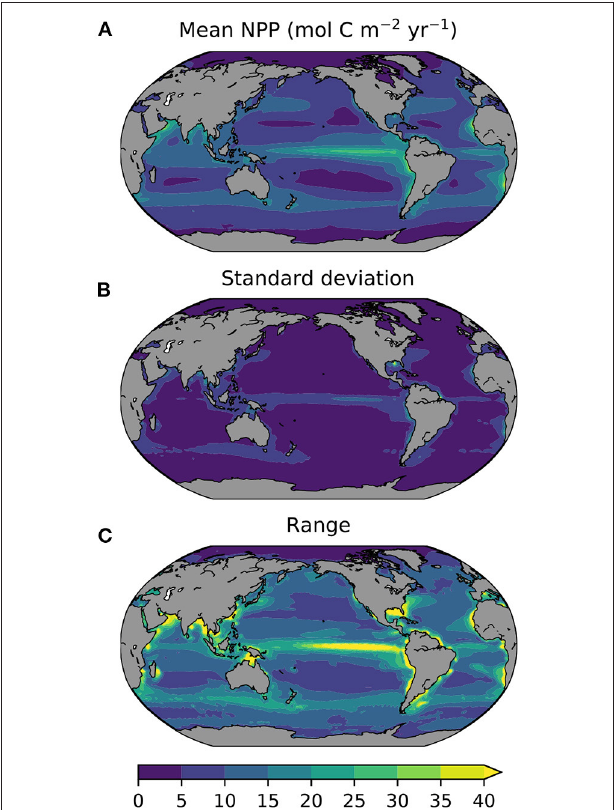
FIGURE 1 | Absolute annual NPP from 16 CMIP6 models for the historical period (1995–2014) presented as (A) multi-model mean, (B) 1 σ , and (C) the full inter-model range. All plots show annual NPP in mol C m − 2 yr − 1